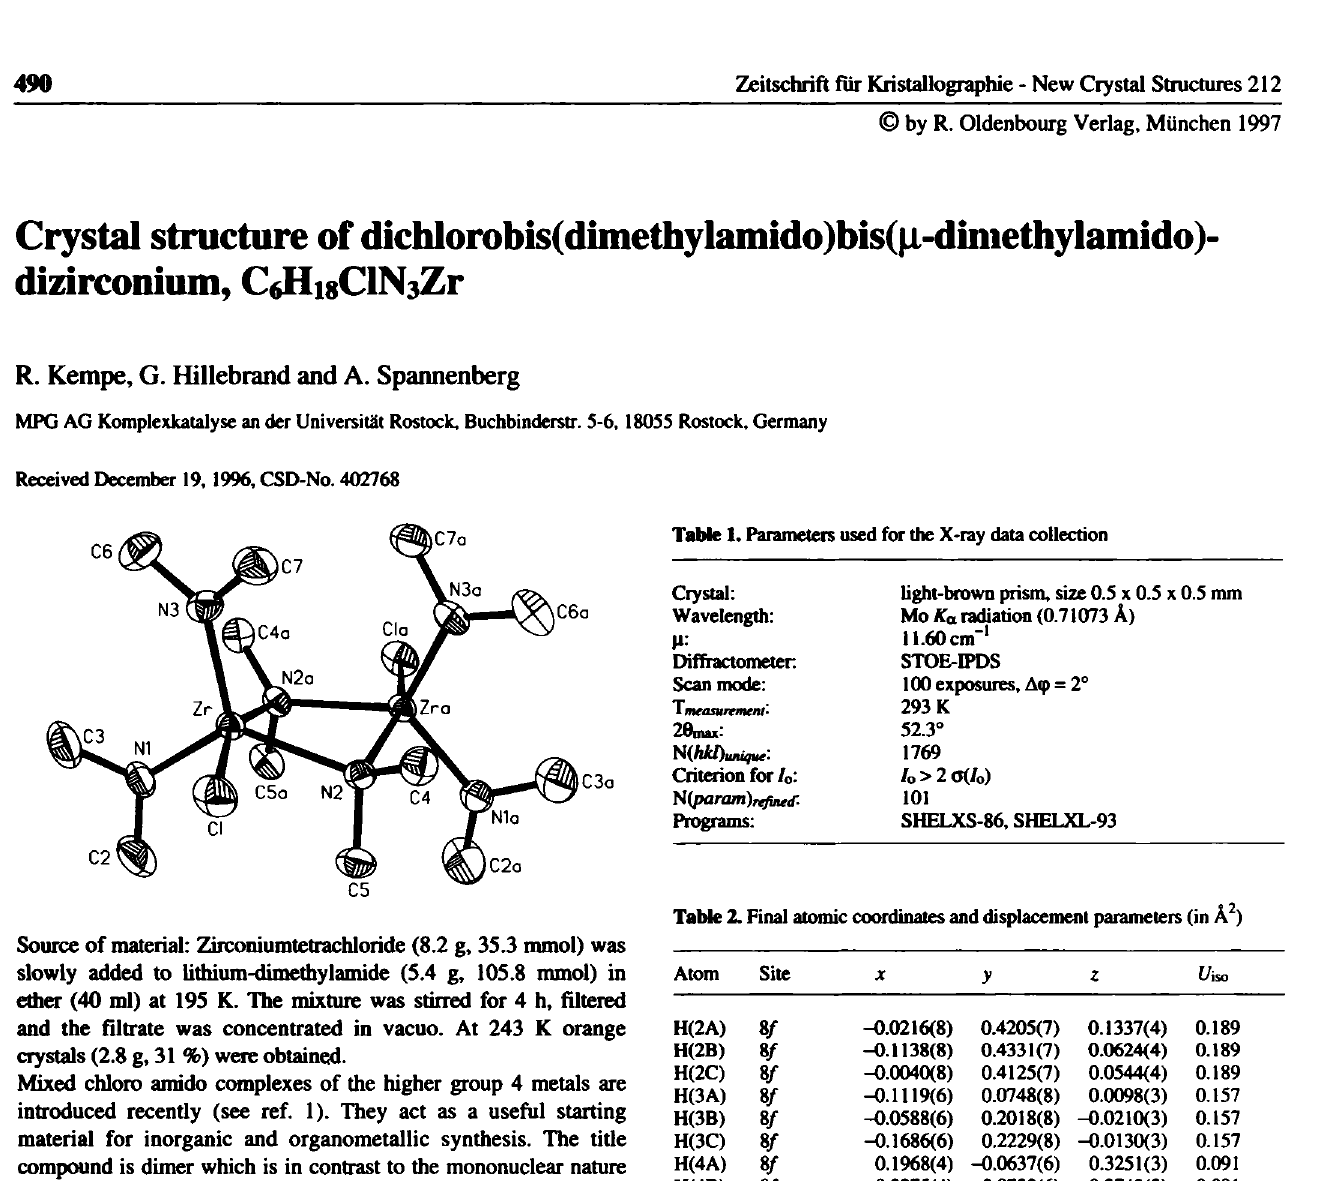
Table 3. Final atomic coordinates and displacement parameters (in Â 2 ) Atom